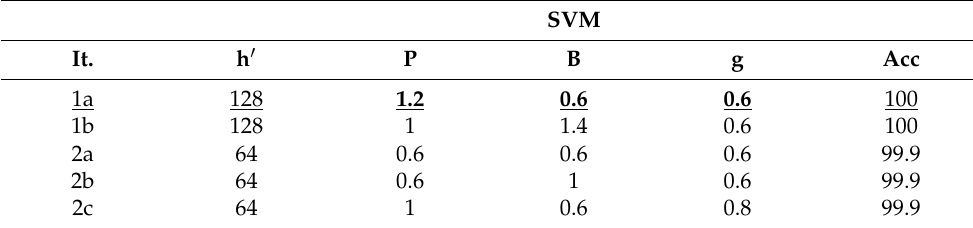
Table 3. Optimization of parameters in the case of SVM model.